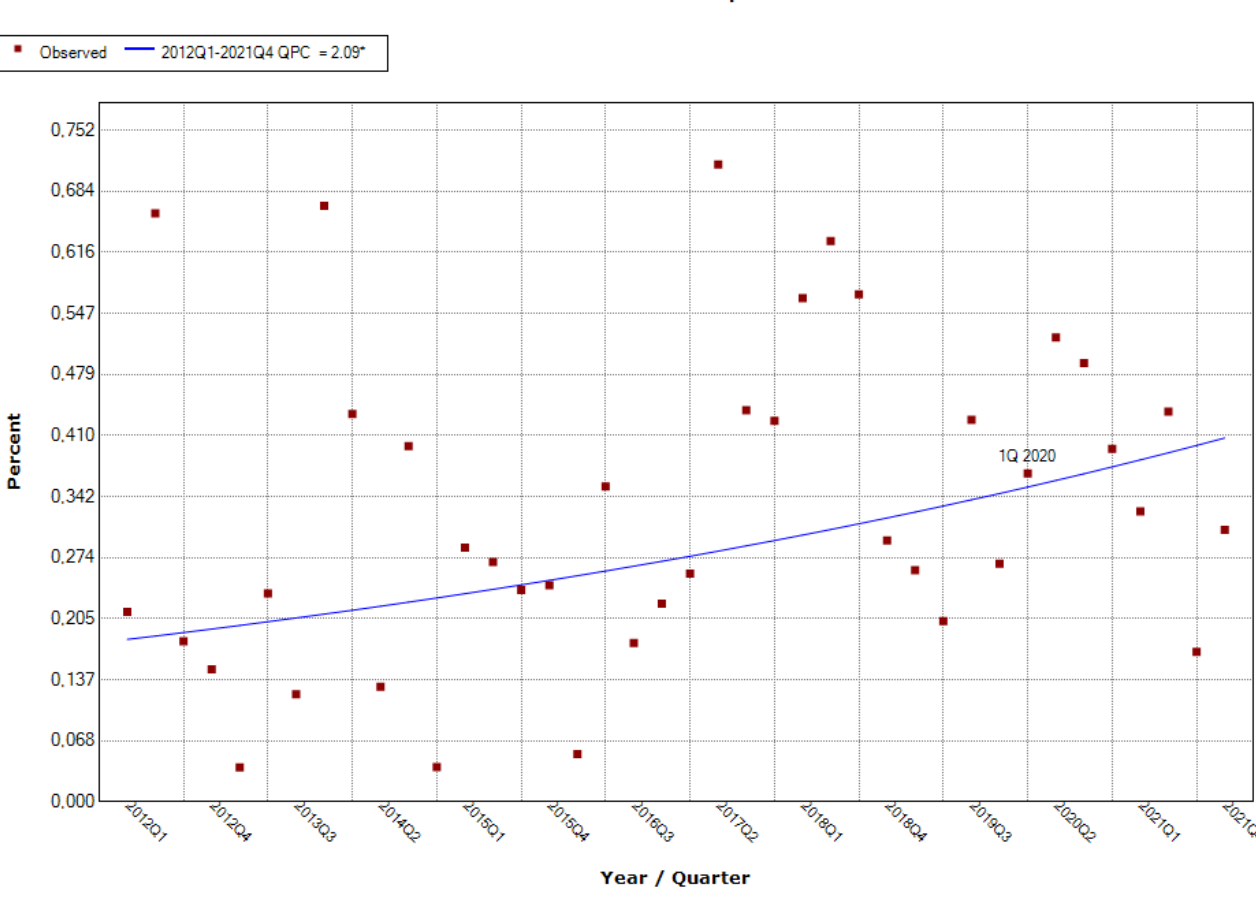
Figure A2. Percentage of products containing astaxanthin in individual quarters in the period from 2012 to 28 November 2021. Joinpoints mark trend turning points. The date above the observation indicates the moment of publication of the scientific opinion/resolution.